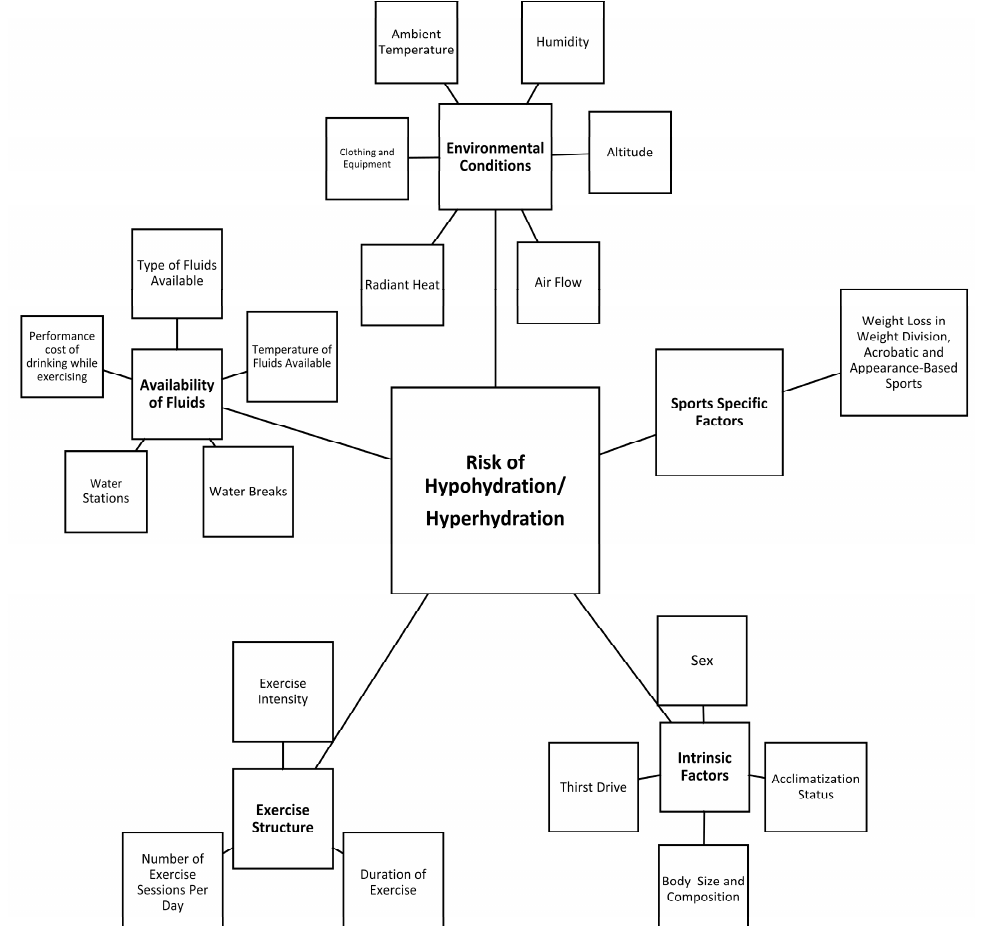
Figure 1. Factors that contribute to the risk of hypohydration or hyperhydration during exercise.